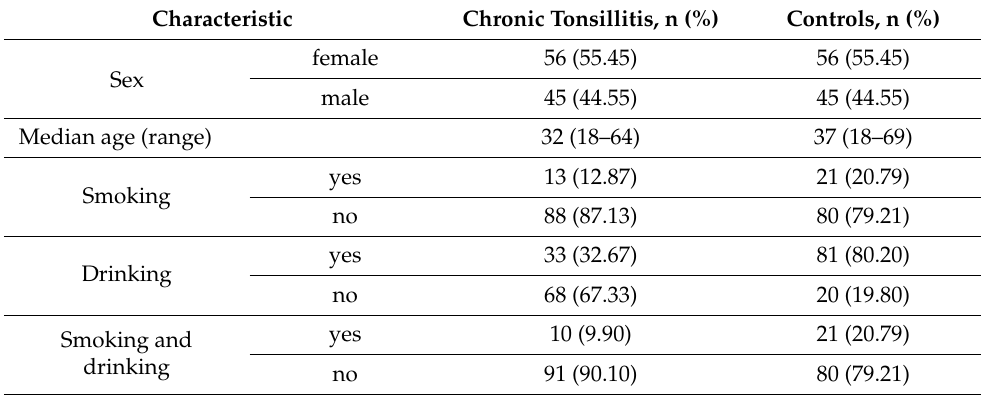
Table 2. Characteristics of the study group.